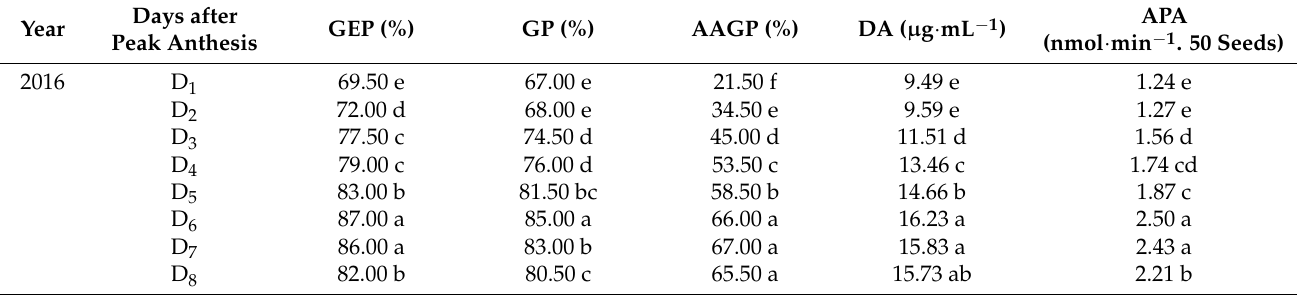
Table 2. Seed quality of K. melanthera as influenced by different days after peak anthesis of seeds during the 2016–2017 trial